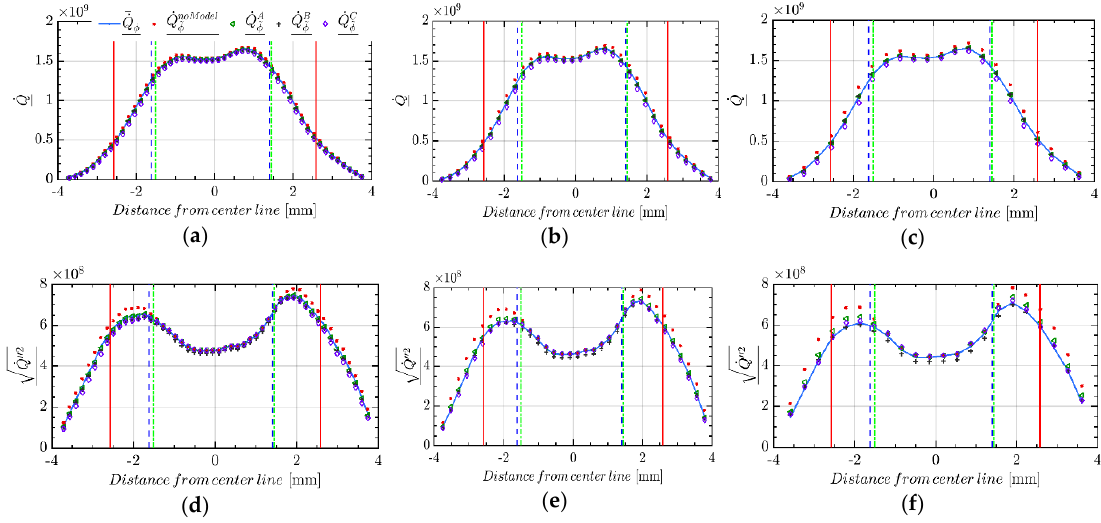
Figure 10. Heat release rate with units (kg/(ms 3 )): ( a , b , c ) Mean; and ( d , e , f ) RMS. Different filter widths are applied: ( a , d ) ∆/∆ DNS = 8; ( b , e ) ∆/∆ DNS = 12; and ( c , f ) ∆/∆ DNS =18. The data are extracted at 𝑡 = 35𝑡 𝑗 . Vertical lines are the same as in Figure 3.